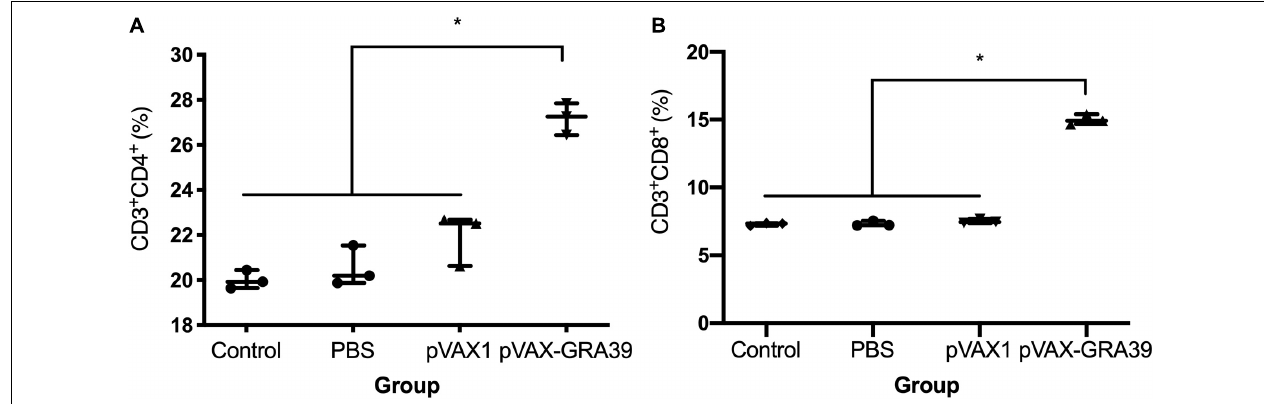
FIGURE 5 | DNA immunization augmented the frequency of antigen-specific T cells in mice. (A) Total numbers of CD3+ CD4+ CD8– T lymphocytes per spleen. (B) Total numbers of CD3+ CD8+ CD4– T lymphocytes per spleen. Data are mean ± SDs (representative of three experiments). * p < 0.05, compared with the control groups.